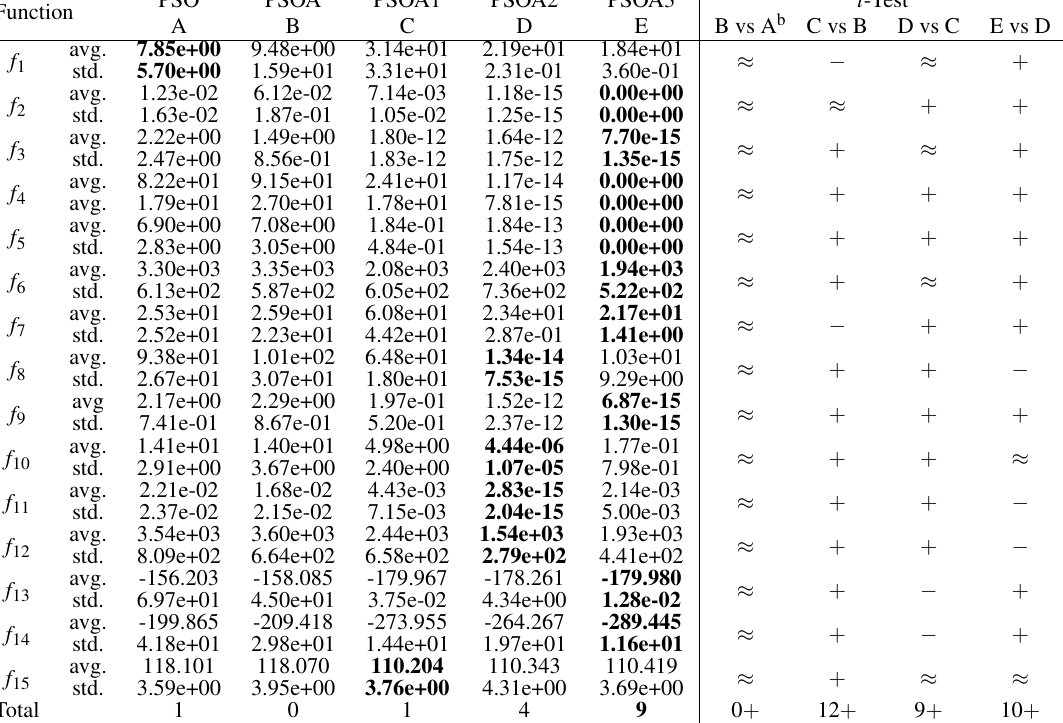
Table 5: Results with four variations of PSOA and PSO on the 15 test functions Function